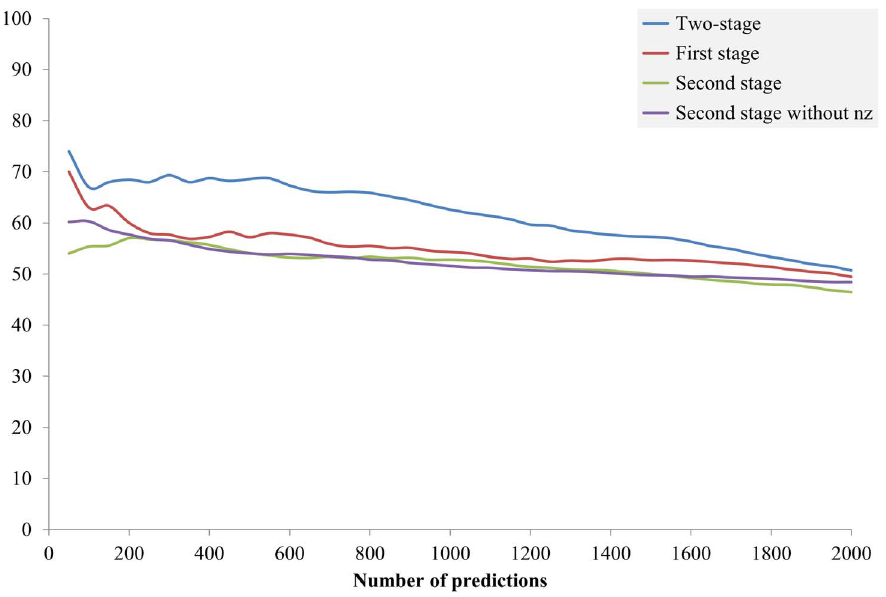
Figure 3.Performance of the proposed two-stage approach and the individual stages. The y -axis is the ratio of correct predictions predicted in the top n predictions ( x -axis).